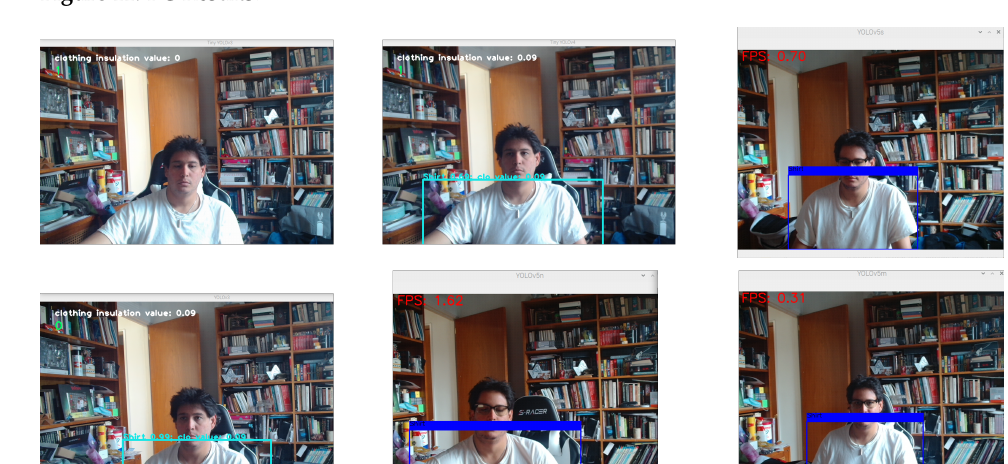
Figure 11. PC Results.